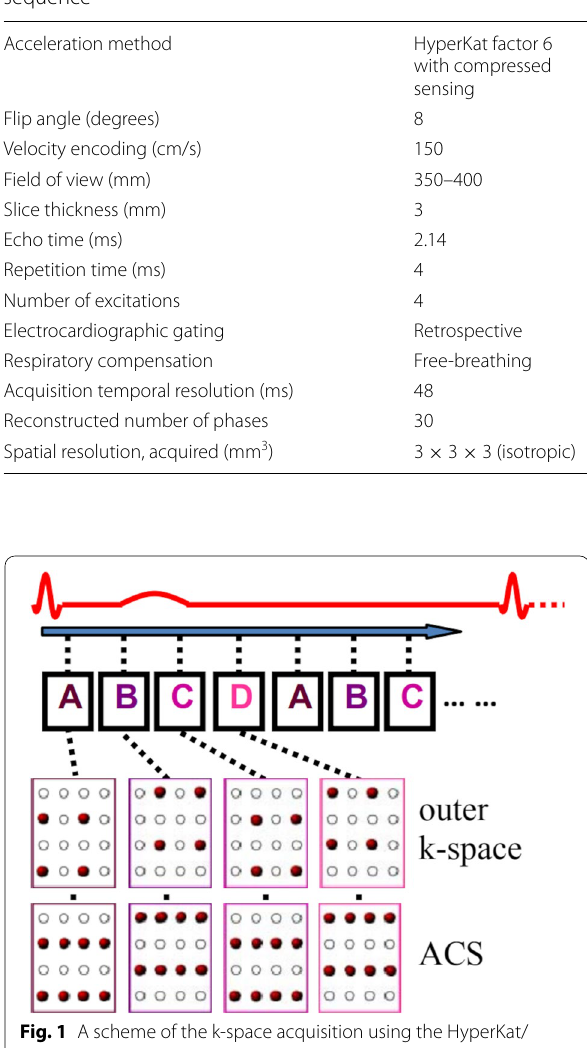
Fig. 1 A scheme of the k‑space acquisition using the HyperKat/ Kat‑ARC sequence. ACS Autocalibration